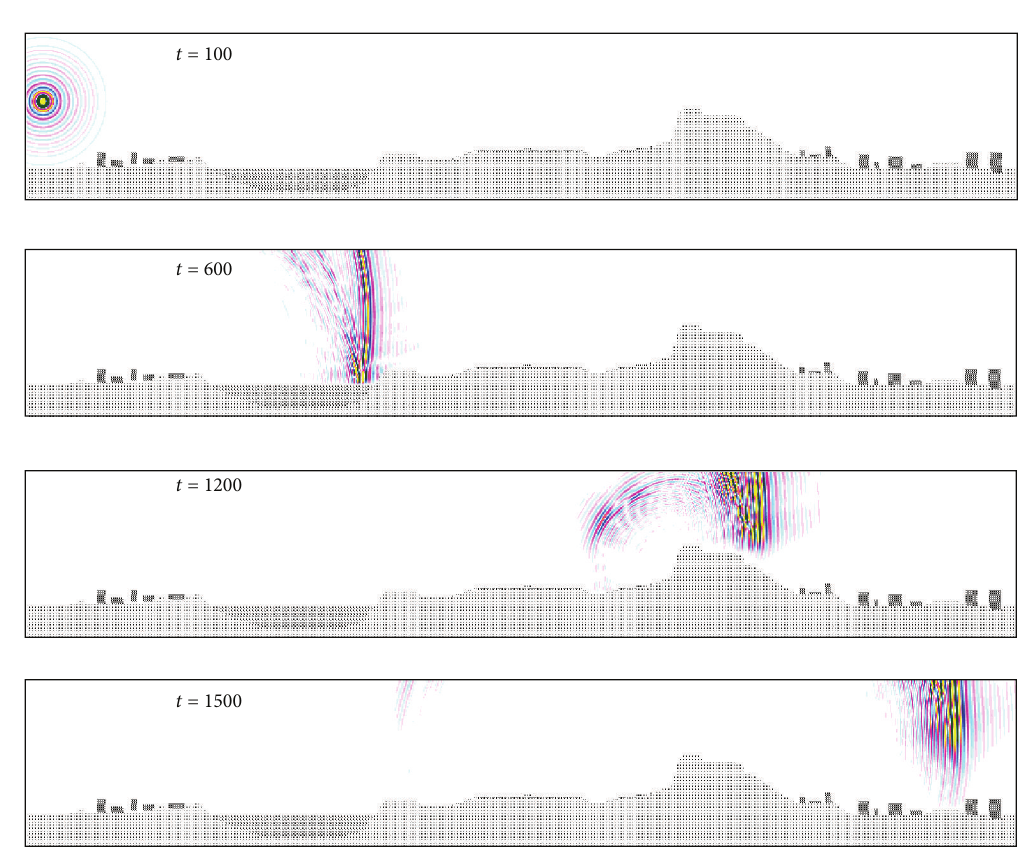
Figure 2: Spatial patterns 𝑈(𝑔, 𝑡) , 𝑔 ∈ Ω int taken at various moments of time 𝑡 for propagation of extra wideband signal.